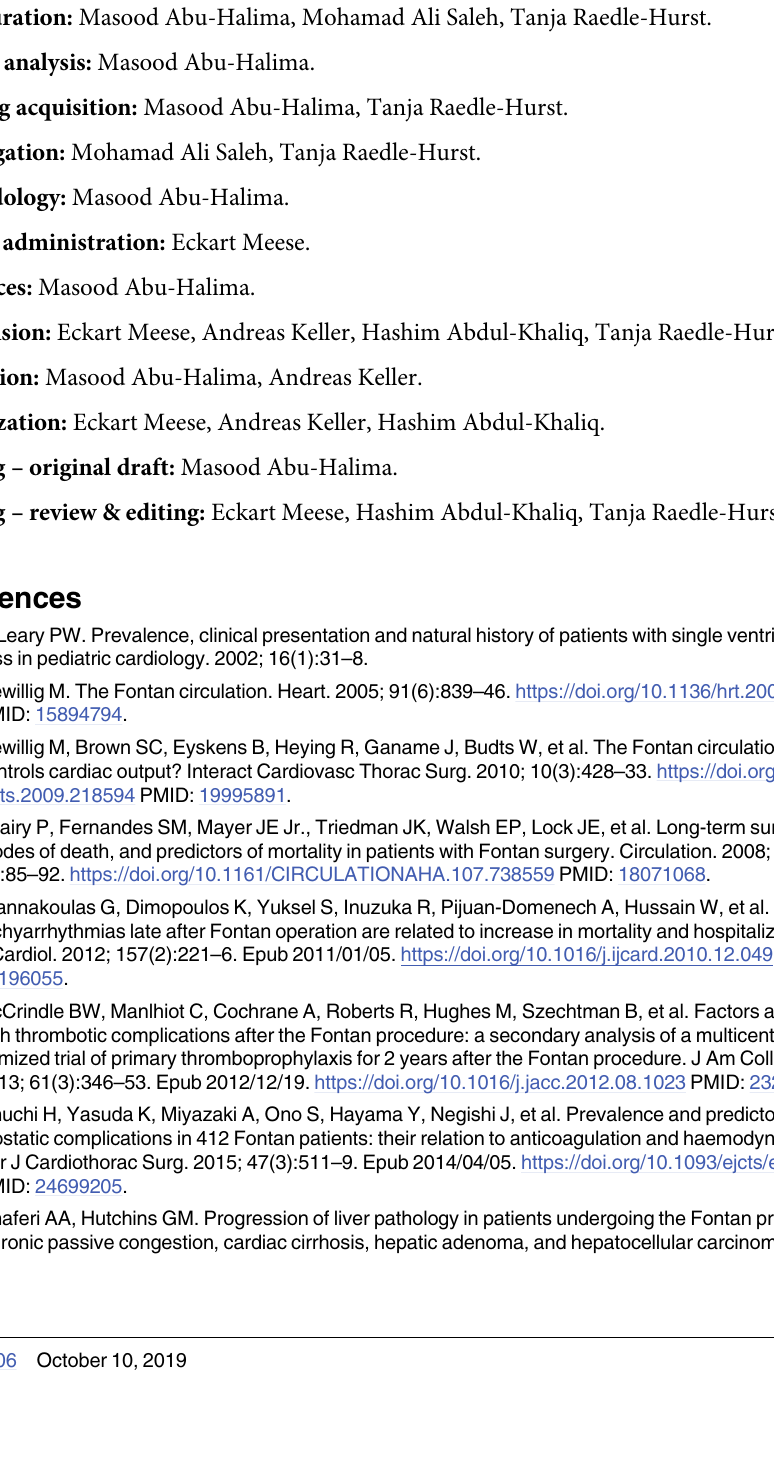
S1 Table. Microarray data of the most abundantly expressed